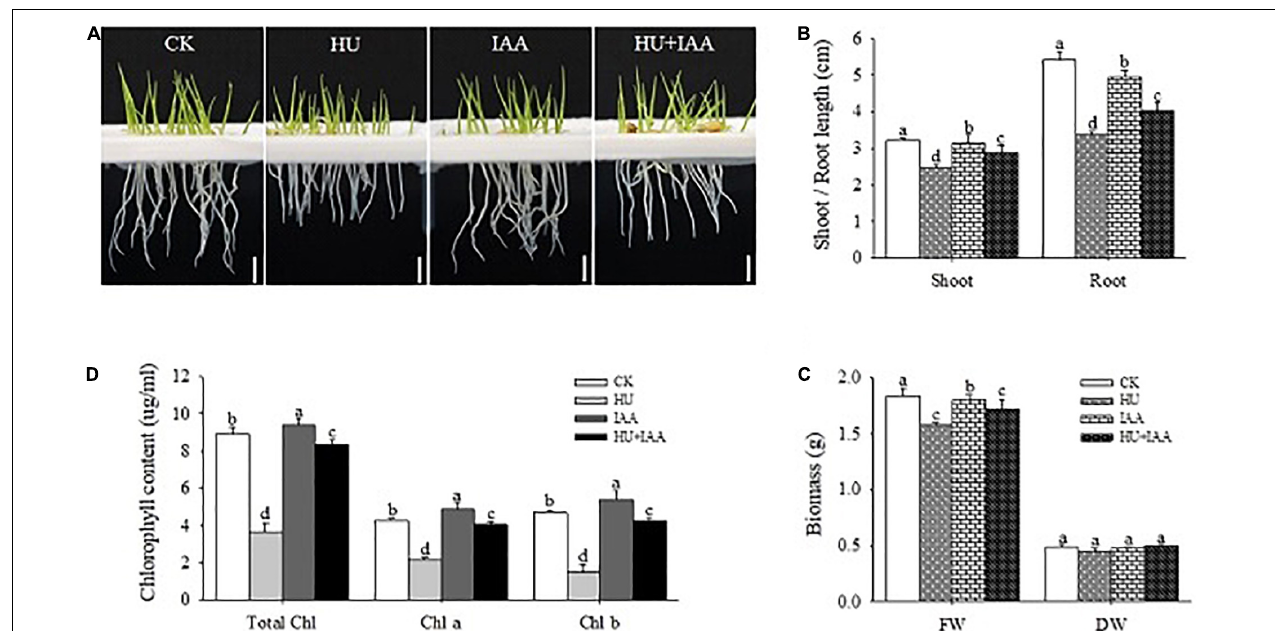
FIGURE 1 | Response of rice seedlings to IAA treatment under HU stress. (A) The phenotypic response of 3-day-old rice seedlings to HU, IAA, and their combination treatment. Bar = 1 cm. (B) Shoot and root length of the 3-day-old rice seedling, (C) plant fresh and dry biomass, and (D) chlorophyll contents. Different letters indicate significant differences between treatments, tested by one-way ANOVA followed by Fisher’s test ( n = 3, p < 0.05). CK, Control; HU, Hydroxyurea; IAA, indole-3-acetic acid.